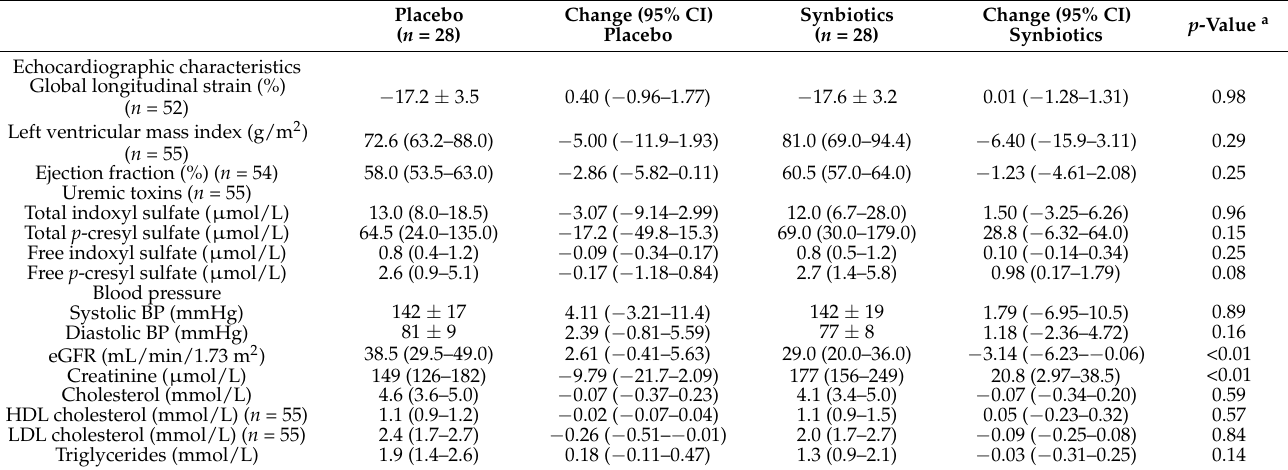
Table 4. Exploratory outcomes at end of intervention and changes from